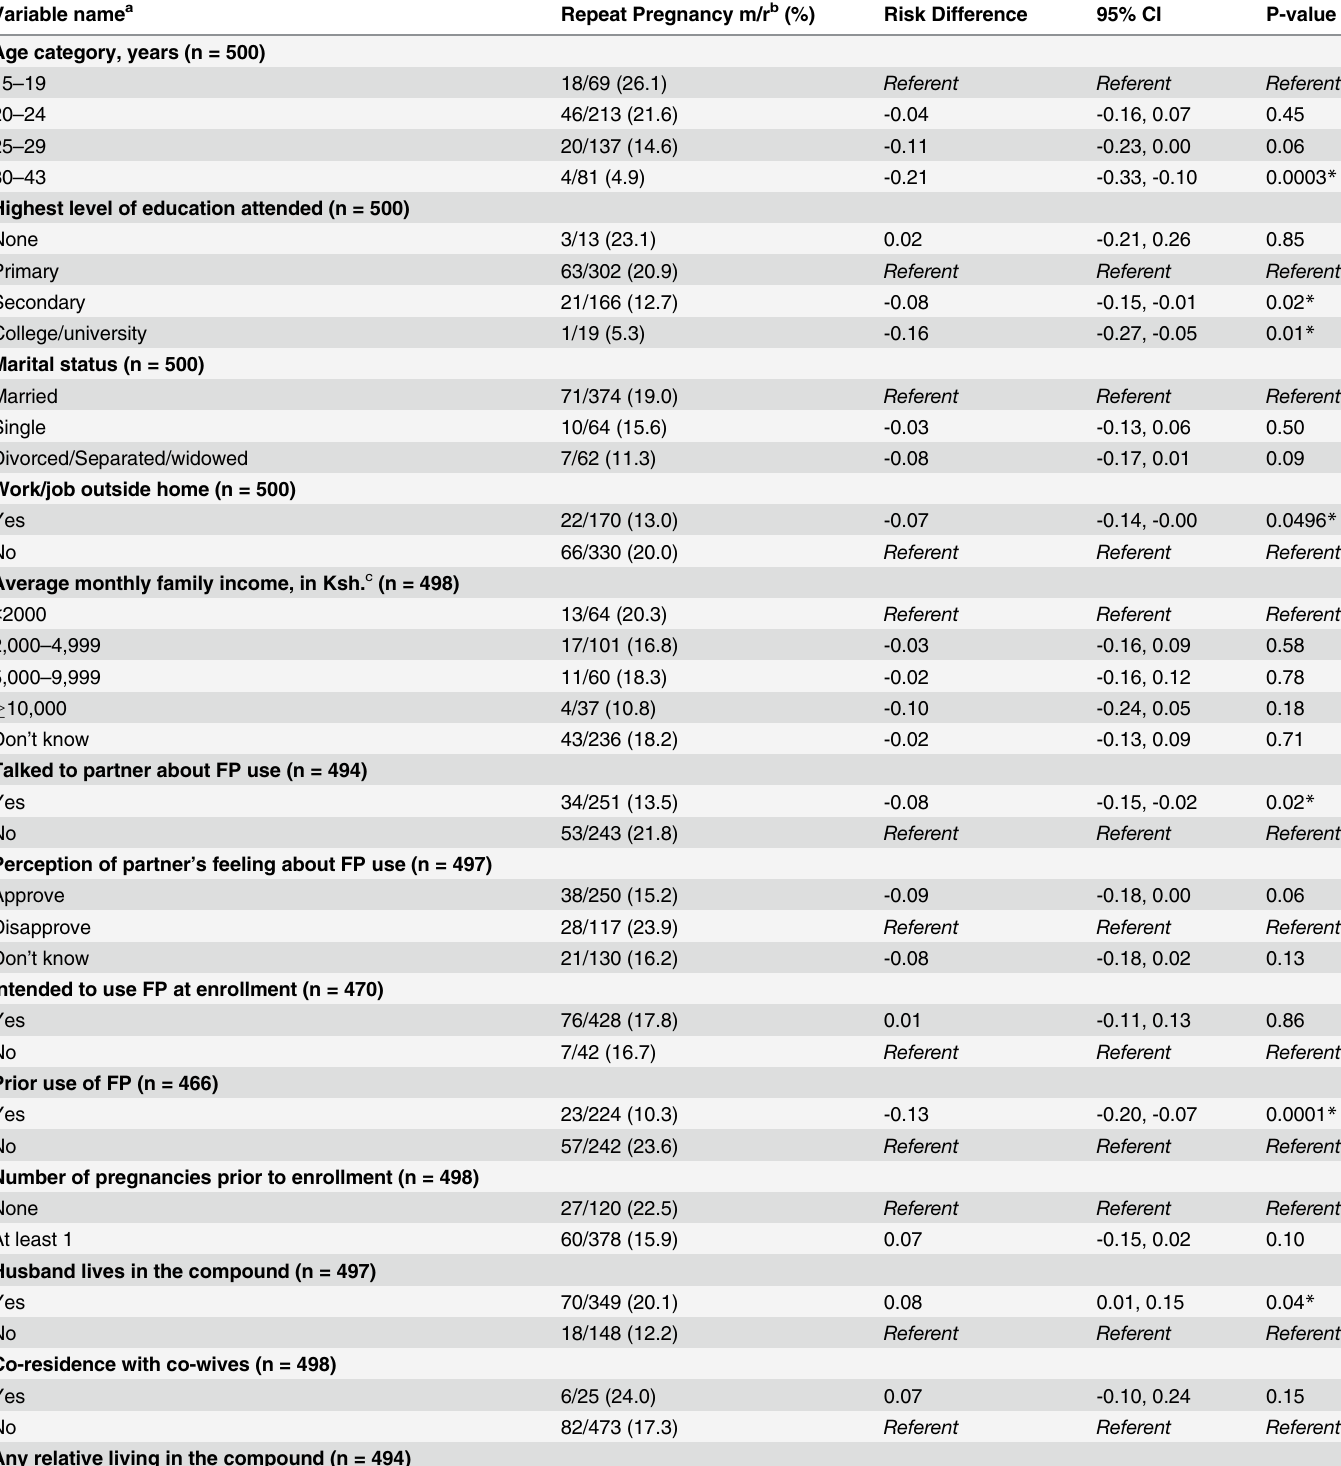
Table 2. Single predictor analysis of determinants and experiences of repeat pregnancy among HIV-infected women in the Kisumu breastfeeding study, Kenya, 2003 –